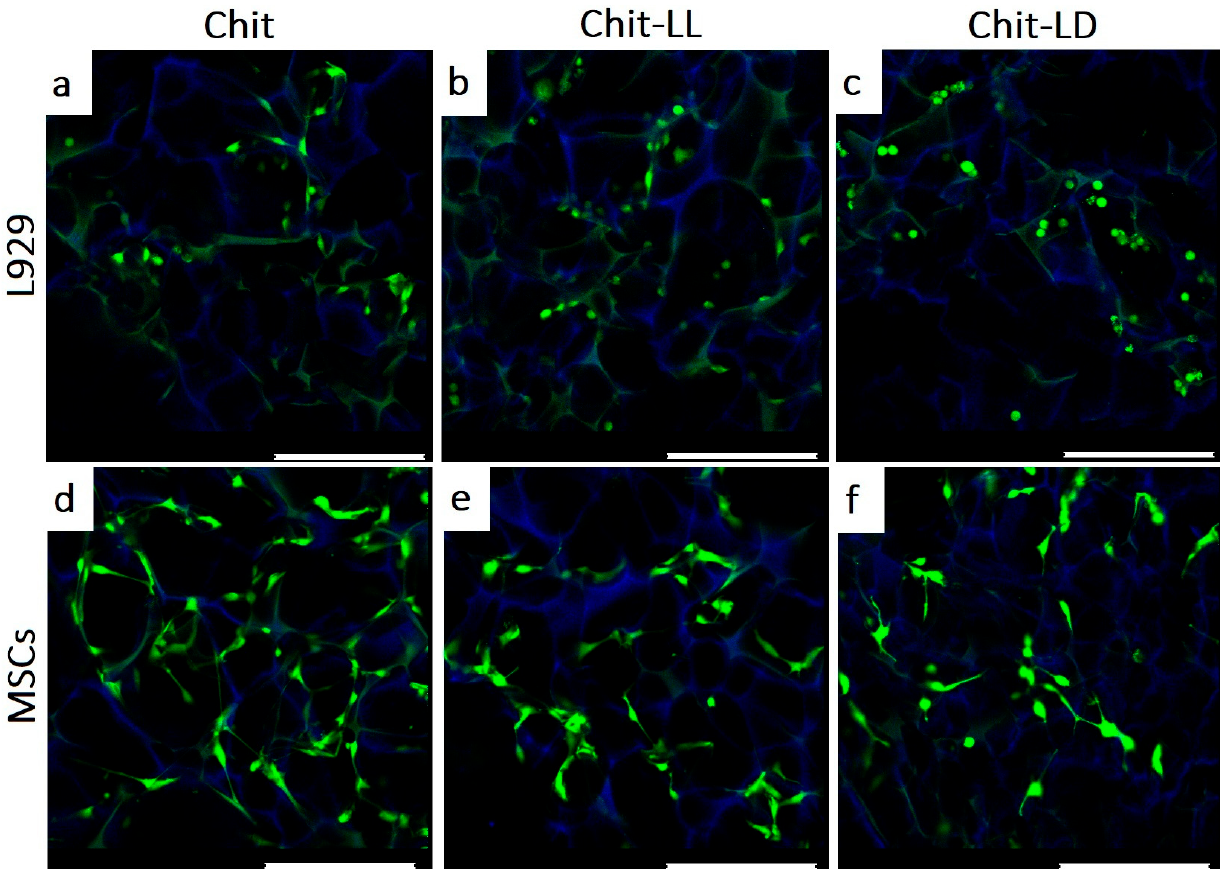
Figure 7. CLSM images of the L929 mouse fibroblasts ( a – c ) and MSCs ( d – f ) after cultivation in the macroporous hydrogels from chitosan (Chit), chitosan-g-oligo(L,L-lactide) (Chit-LL), and chitosan-g-oligo(L,D-lactide) (Chit-LD) hydrogels for 3 days. The alive cells (in green) and the hydrogels (in blue) were stained with calcein AM and DAPI, respectively. The scale bar is 250 μ m.